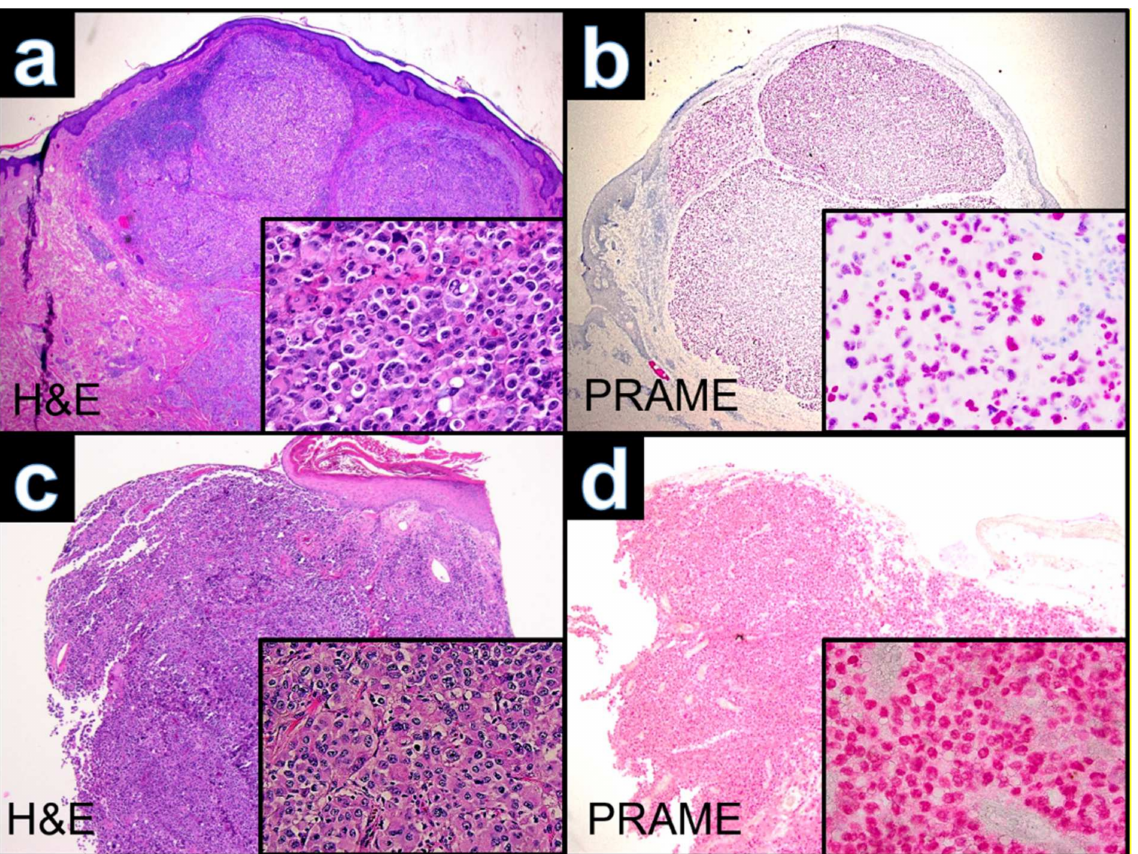
Figure 5. ( a ) Case WUE3: Polypoid tumor of a 79 year old patient from the arm (H&E × 40). Inset H&E × 400. ( c ): Case WUE4: Tumor of a 75 year old patient from the scalp (H&E × 40). Inset H&E × 400. ( b,d ):Cases WUE3 and WUE4: The tumor cells are diffusely immunopositive for PRAME (nuclear labeling) (PRAME × 40). Inset highlights that PRAME labeling is nuclear (PRAME ×